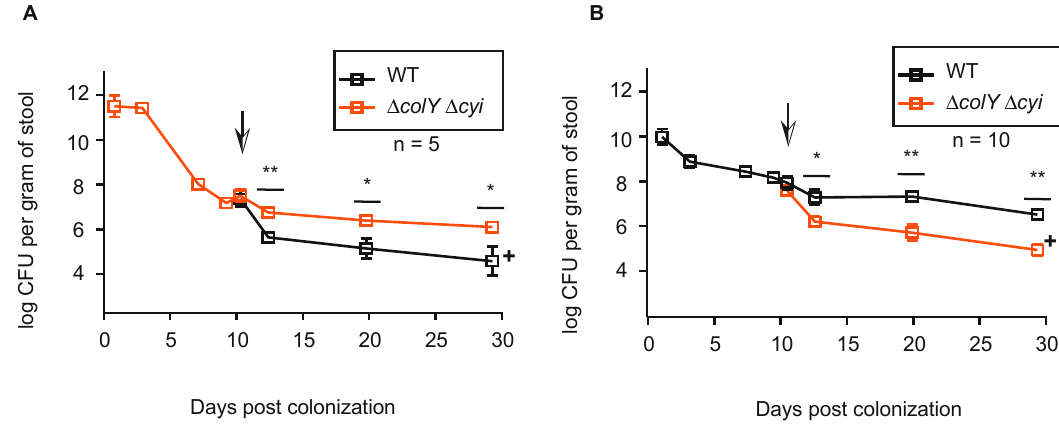
Figure 5. Commensal strain invasion. ( A , B ) Groups of 6- to 8-week-old C57BL / 6 mice were inoculated with either the wild-type strain or the ∆ colY ∆ cyi strain. On day 9, as represented by the down arrow, the mice were inoculated with the wild-type strain ( A ) or the ∆ colY ∆ cyi strain ( B ). Each square represents the mean and standard deviation from the mean of all individual mice. Limit of detection was 10 2 . If colonies were too numerous to count on a plate, the corresponding animal was excluded from the data for that day. + indicates the wild-type strain was not recoverable from one mouse; ++ indicates the ∆ colY ∆ cyi strain was not detected from two mice by the termination of the experiment. Significant p values are noted (* p > 0.05, ** p > 0.005) and were calculated using a two-tailed unpaired Student’s t test.